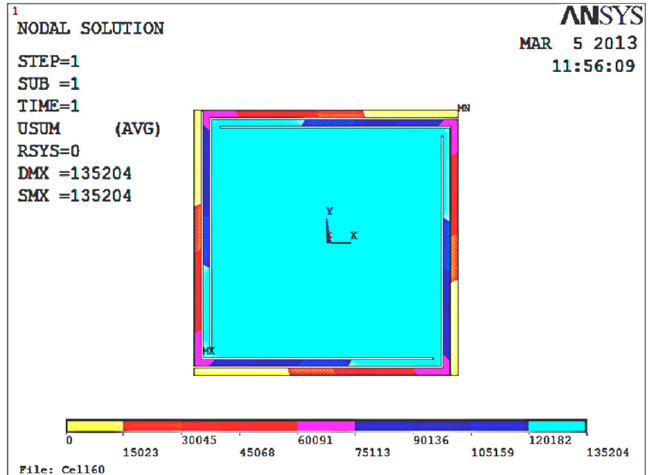
Figure 6. Displacement contour under +1 g acceleration.